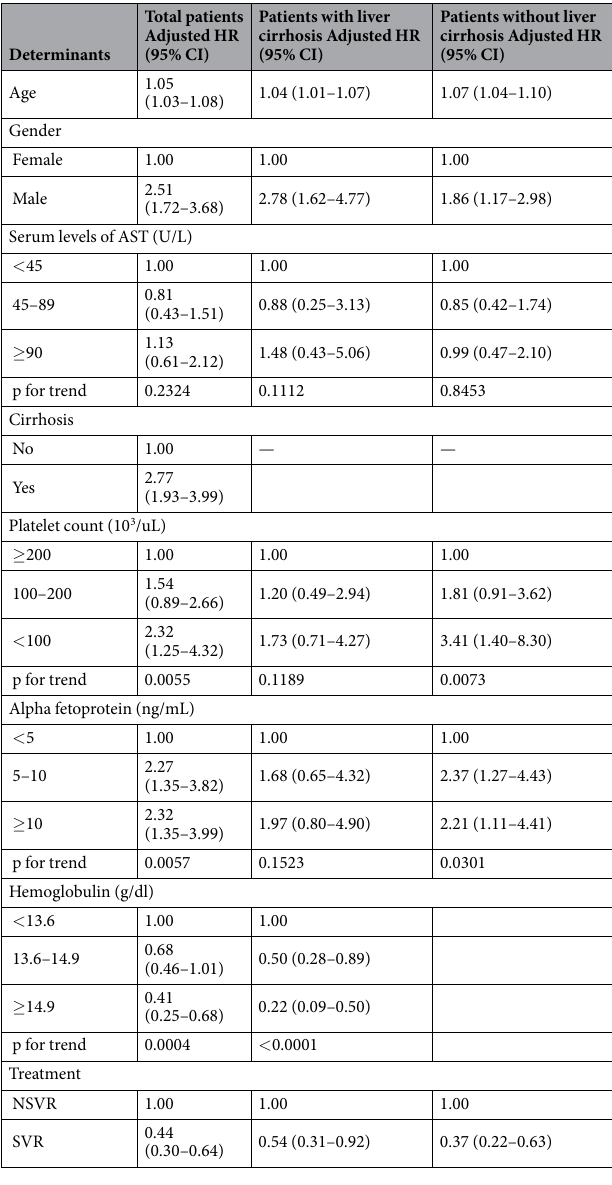
Table 3. Adjusted hazard ratios and 95% confidence intervals of pretreatment predictors for HCC, stratified by presence of liver cirrhosis at study entry. AST: aspartate aminotransferase; SVR: sustained virological response; NSVR: non-sustained virological